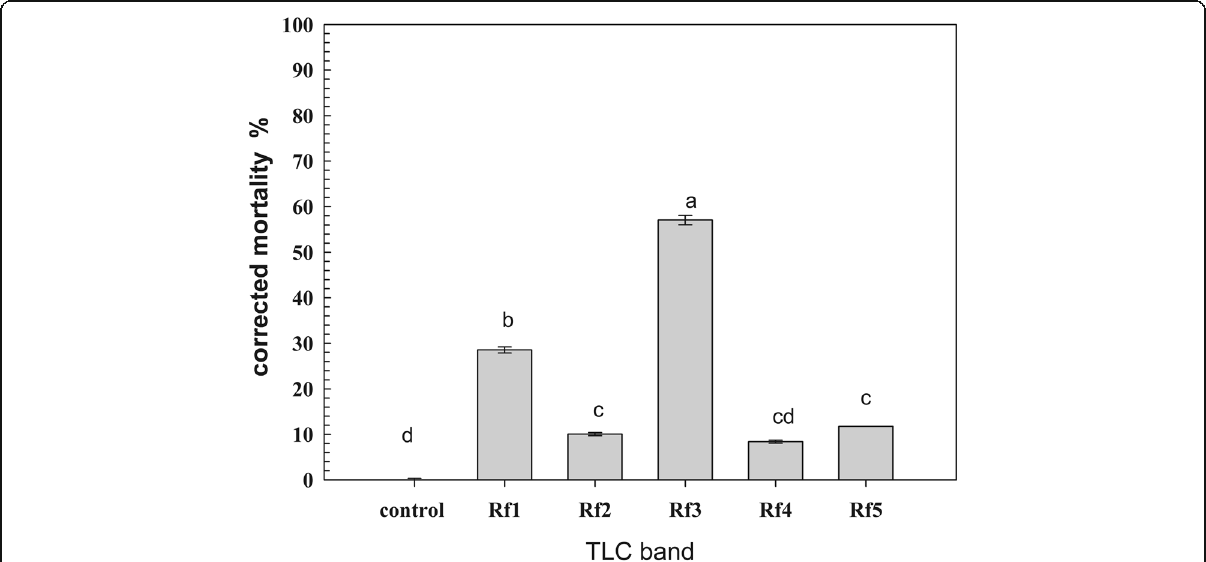
Fig. 2 Lethal activity of TLC fractions of ethyl acetate extract of A. melleus on T. urticae. Error bars are corresponding to standard error. Different letters (superscript a and b) indicate a significant difference according to Duncan ’ s multiple range test